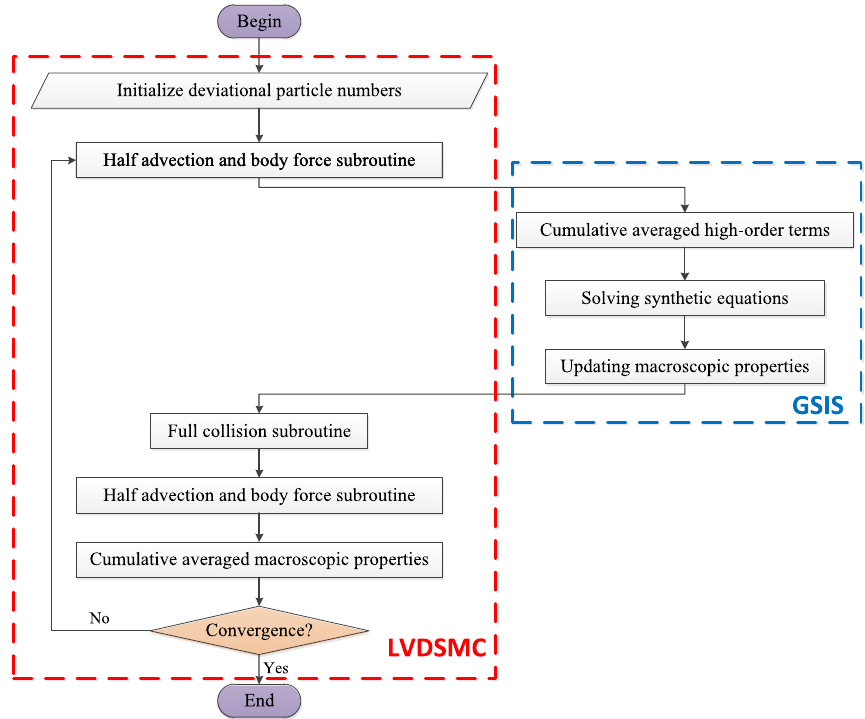
Fig. 1 Flowchart of the GSIS-LVDSMC coupling algorithm. The red dashed box represents the original LVDSMC, and the blue dashed box indicates the additional part of GSIS. Thus, the original code structure of DSMC is maintained, and the GSIS appears as a